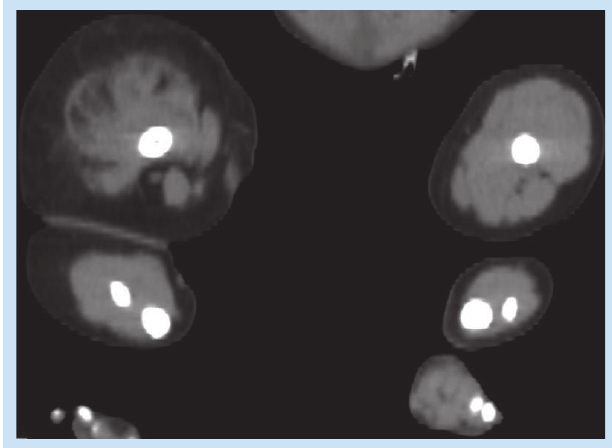
Fig. 3. Coronal CT with fatty infiltration of